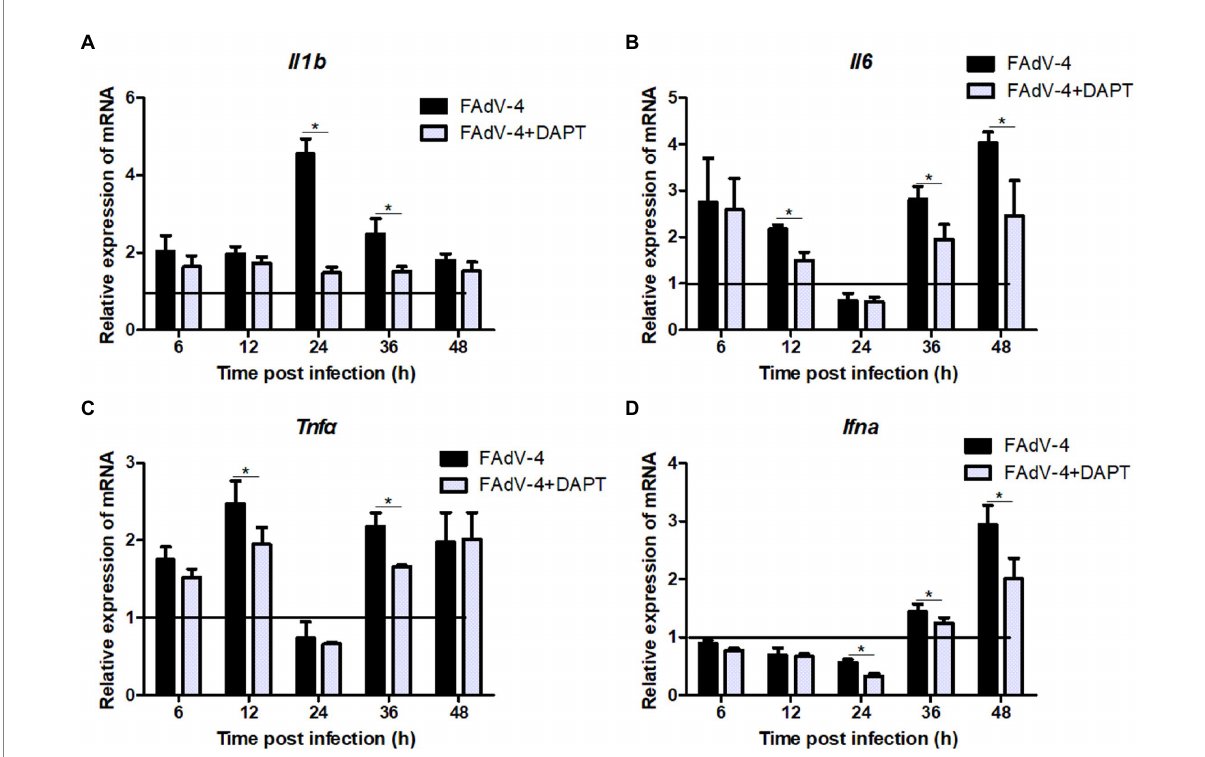
FIGURE 7 Restraining Notch signaling with DAPT inhibits expression of the inflammatory and immune cytokines induced by FAdV-4 infection. Cells were harvested at different time, then expression of the target gene il1b (A) , il6 (B) , tnf α (C) and ifn α (D) was evaluated by qPCR. The y axis represents the fold change in target gene expression in in FAdV-4 group and FAdV-4+ DAPT group compared with that of the control and the above line ( y = 1) on the x -axis represents the control. Data are shown as mean (SD) with n = 3 per group. * p < 0.05, represents the comparison between group FAdV-4 and group FAdV-4+